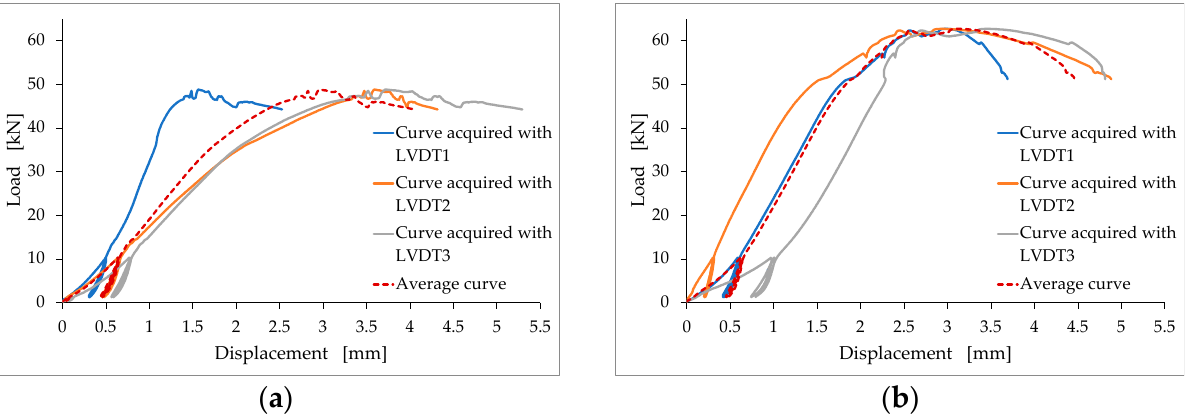
Figure 5. Significant rotations of the upper face under uniaxial compression: ( a ) TQ12 specimen; and ( b ) LT9 specimen.